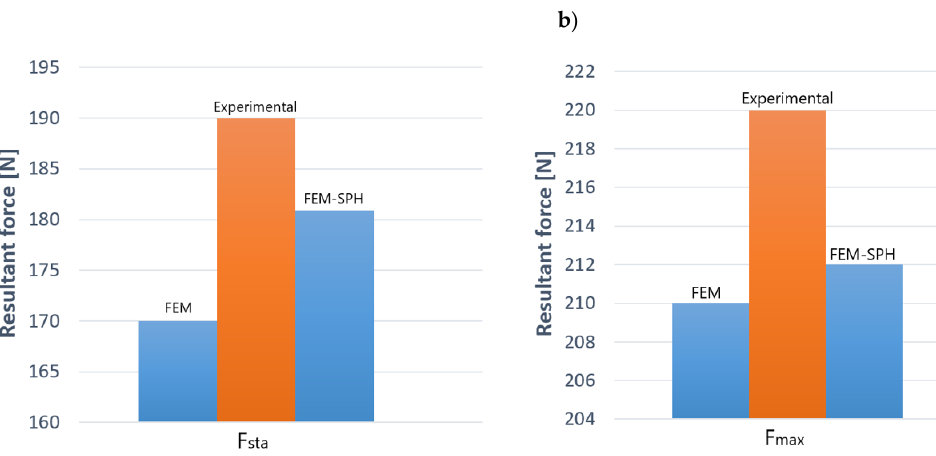
Figure 15. A comparison of the resultant force of the experiment and the simulation: ( a ) cutting force at steady state, ( b ) maximum force.